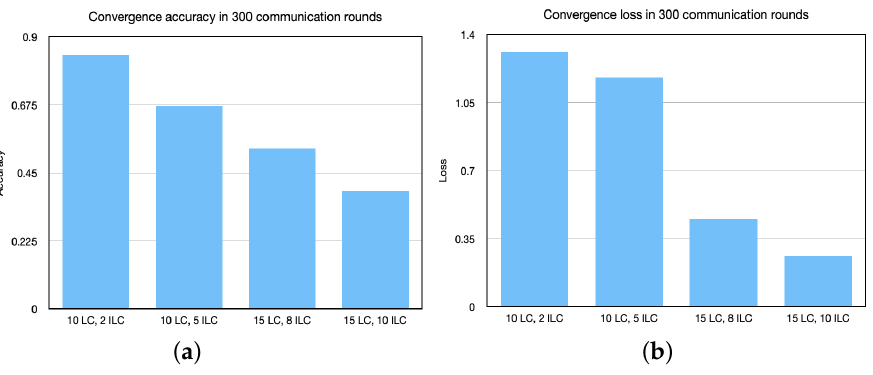
Figure 4. Comparison of SHFL training accuracy and training loss for different numbers of LCs and ILCs in the MNIST dataset, ( a ) training accuracy over MNIST; ( b ) training loss over MNIST.